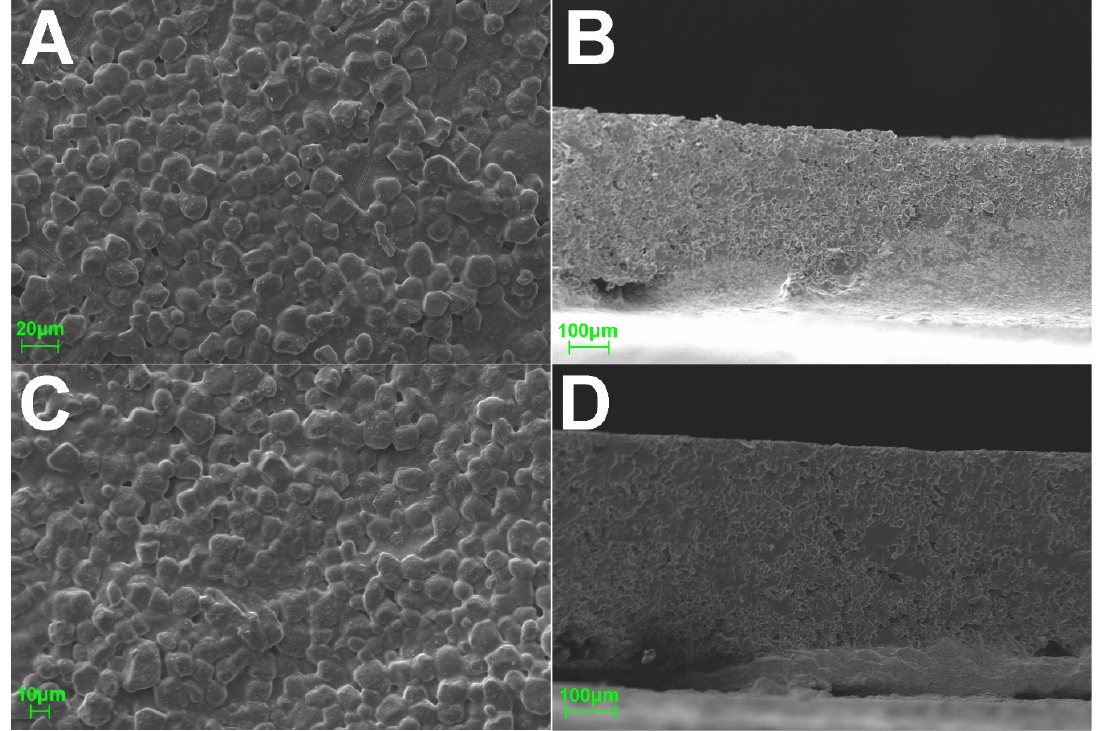
Figure 2. SEM micrographs of the upper and side surfaces of plain ( A , B ) and nine-pass (9)-printed ( C , D ) sugar sheets.